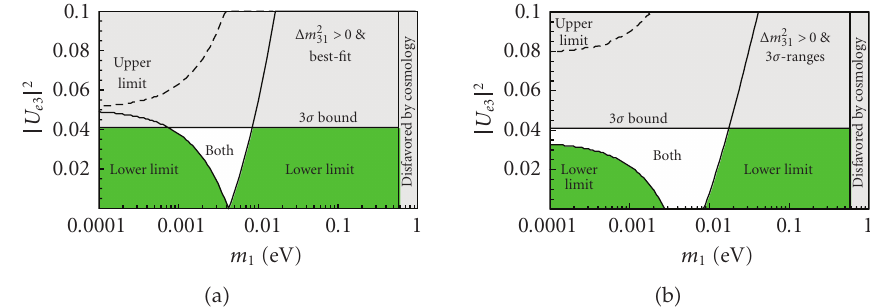
Figure 2: Regions in the m 1 - | U e 3 | 2 -plane in which upper and lower limits on | U e 3 | 2 can be obtained. In the white region both is possible, depending in particular on the Majorana phase α . The left plot is for the best-fit values of the oscillation parameters, the right plot for the current 3 σ ranges, in both we have also indicated the current 3 σ bound on | U e 3 | 2